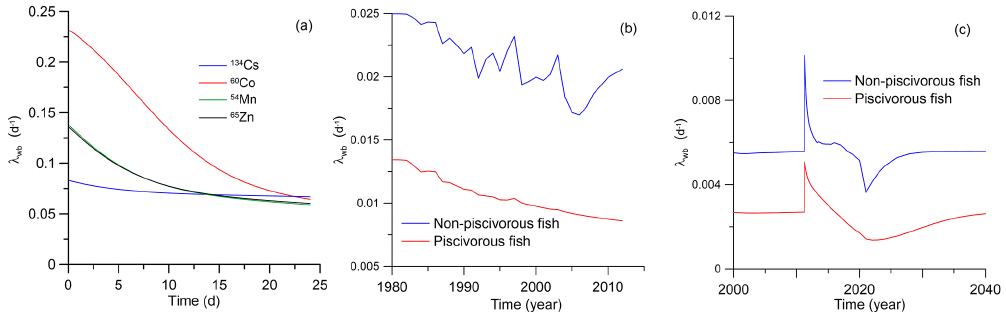
Figure 11. The calculated λ wb for three scenarios: (a) the pulse-like feeding experiment (Mathews, Fisher (2008), (b) the release of 60 Co during normal operation of the Forsmark NPP and (c) the accumulation of 90 Sr in the fish due to the FDNPP accident.